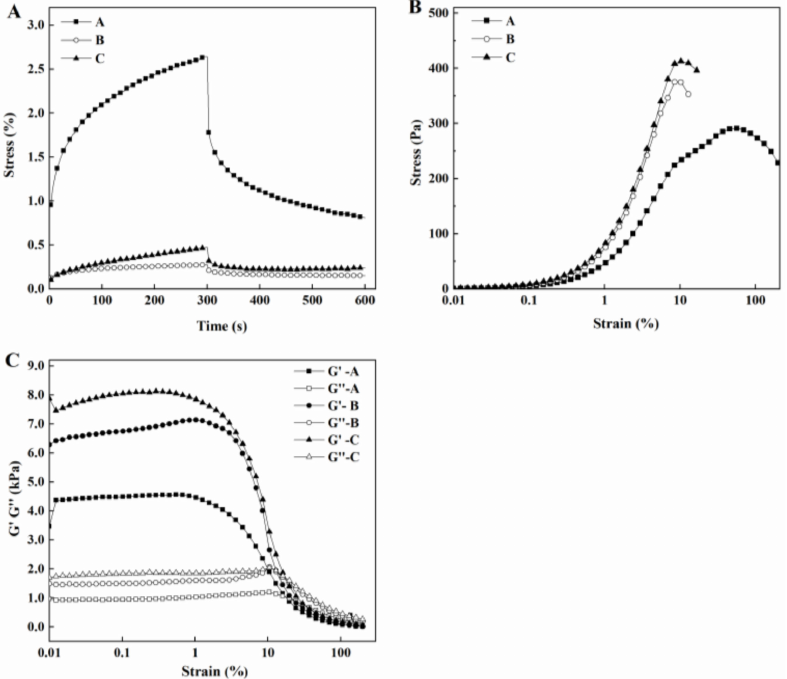
Figure 6. Creep-recovery curve ( A ), strain creep curves ( B ), and changes in G’ and G” as a function of strain ( C ) of tofu manufactured from coagulant fermented by L. paracasei ( A ), L. plantarum ( B ), and natural bacteria ( C